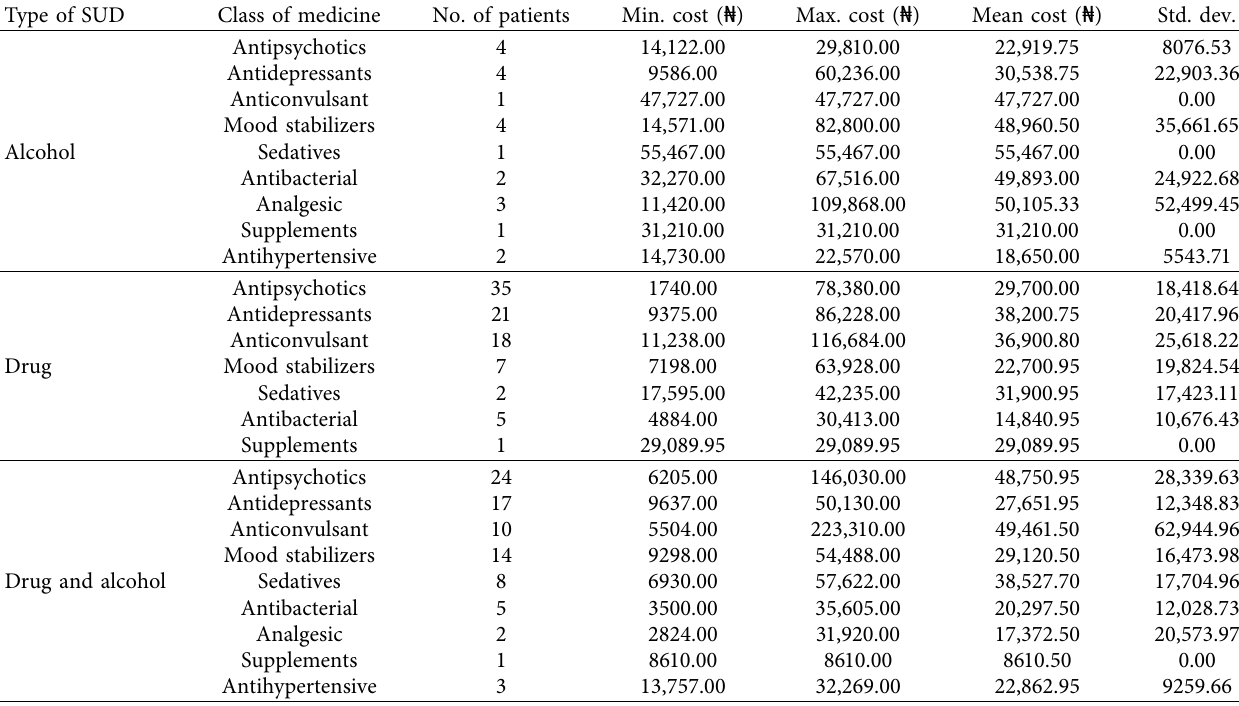
Table 4: Mean cost of treatment across demographic characteristics of the patients.